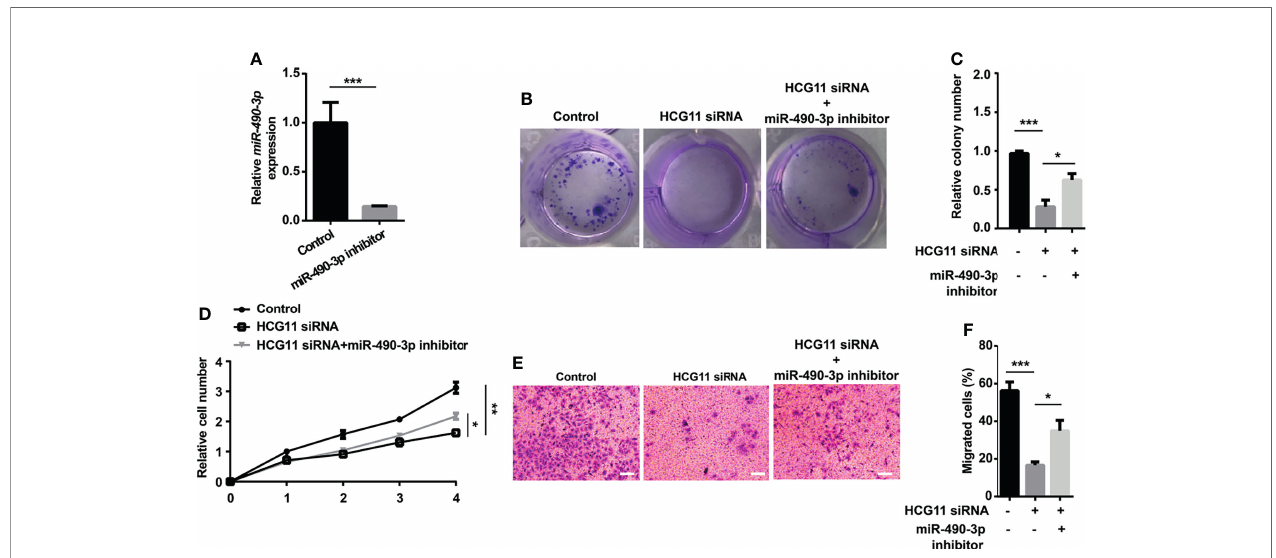
FIGURE 6 | Oncogenic function of HCG11 was partially reversed by miR-490-3p in NPC cells. (A) QPCR analysis of miR-490-3p in 5-8F cells (control, miR-490-3p inhibitor). (B – D) Proliferation capacity of 5-8F cells transferred with miR-490-3p inhibitor or HCG11 siRNA was con fi rmed using colony formation assay (B, C) and CCK8 assay (D) . (E, F) Cell migration of 5-8F cells transferred with miR-490-3p inhibitor or HCG11 siRNA was con fi rmed by transwell assay. Data were presented as Mean ± SEM. * p < 0.05, ** p < 0.01, *** p < 0.001. These experiments were repeated for three